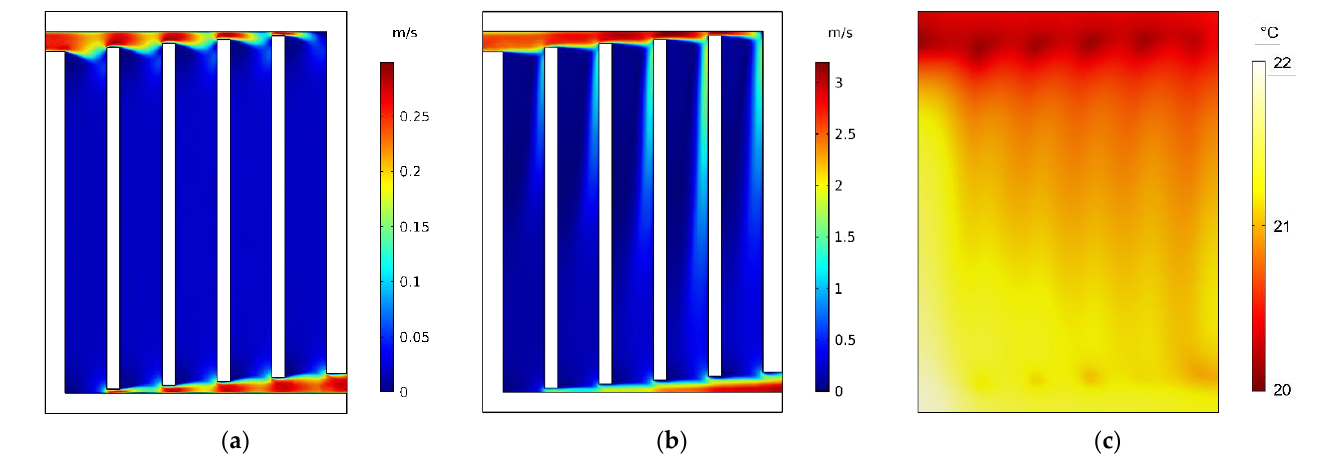
Figure 8. Simulation of velocity and temperature distribution of a cooling plate (fluid inlet at top left and outlet at bottom right): ( a ) velocity distribution for a low flow rate of 0.1 L/min, ( b ) velocity distribution for a high flow rate of 1 L/min, and ( c ) temperature distribution for 1 L/min and 20 ◦ C water inlet temperature after discharging with 3 C.